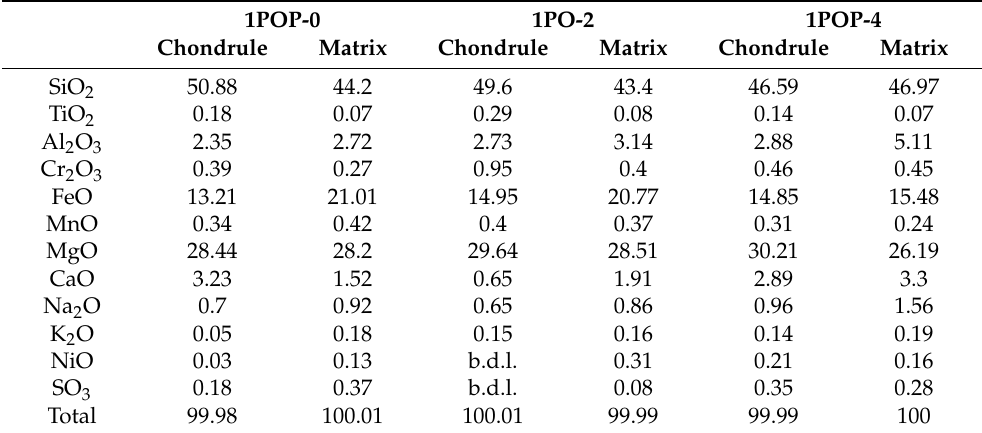
Table 1. Bulk composition (in wt.%) of chondrules and matrix from the Kargapole (H4)